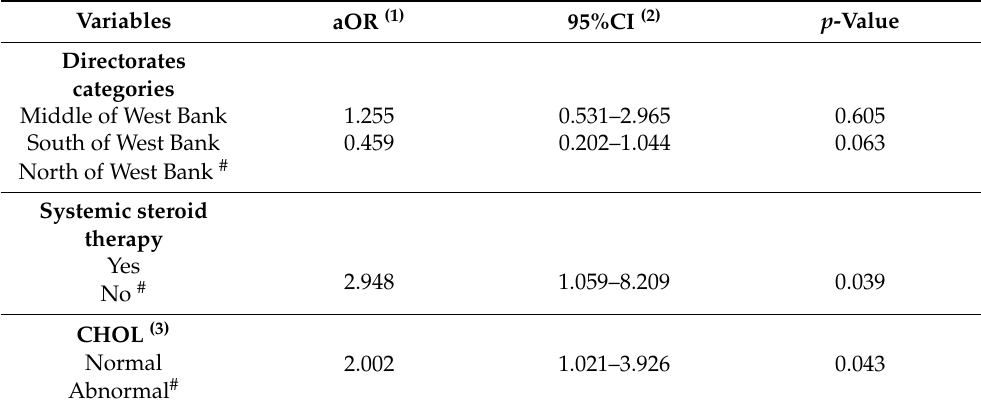
Table 5. Multivariate logistic regression for factors associated with NPDR and threatened vision (PDR,